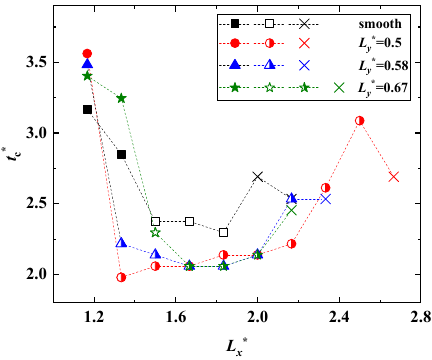
Figure 13. The variations of the contact times with L x * at various L y * on the S2 surface.